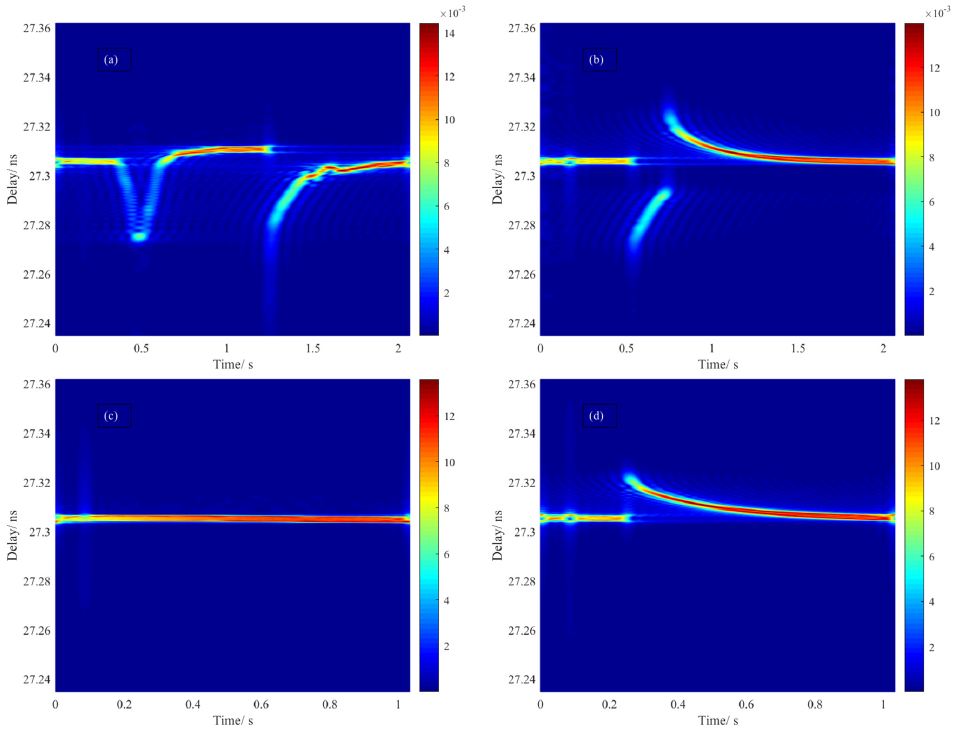
Figure 11. Transmission spectrum at different stages of discharge: ( a ) initiation of predischarge followed by normal discharge; ( b ) initiation of redischarge; ( c ) duration of discharge; ( d ) termination of discharge.